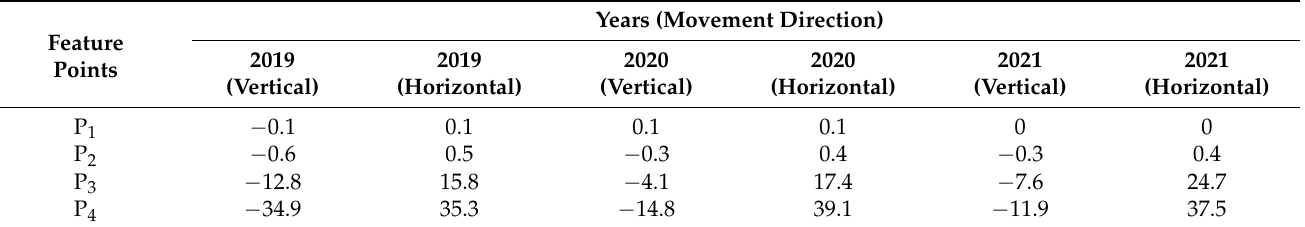
Table 2. Accumulated deformation along the vertical and horizontal directions from 2019 to 2021 (in